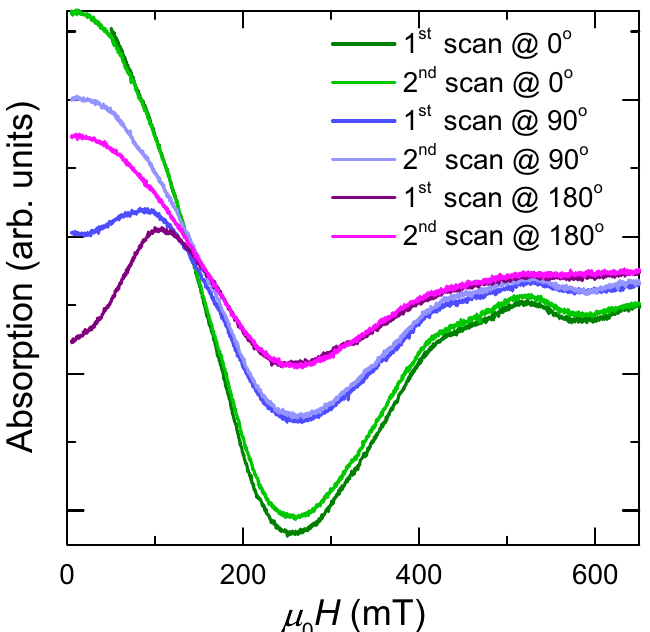
Figure 6. Angular dependence of the FMR spectra at 10 K. First and second scans of the initial spectrum and after rotations by 90° and 180°, respectively.